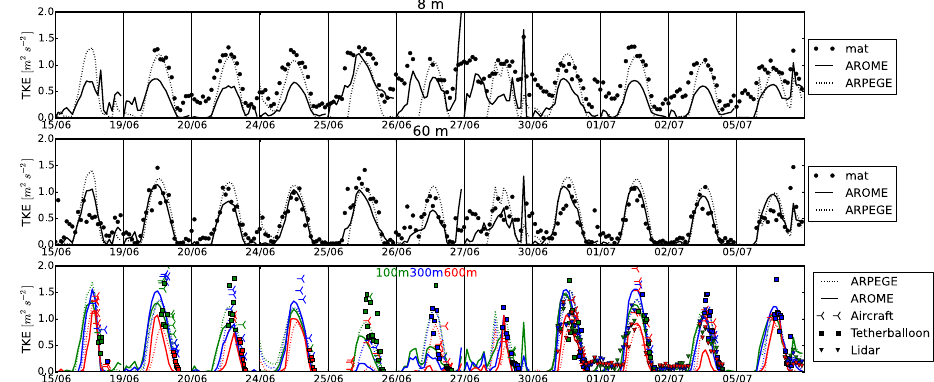
Figure 9. Time series of turbulent kinetic energy observed (in symbols) or simulated by AROME (full line) and ARPEGE (dotted line) at (top) 8m above ground level for observations, 11m for AROME and 17.5m for ARPEGE, (middle) 60m above ground level and (bot- tom) 100, 300 and 600m above ground level for the different IOPs from 15 June to 5